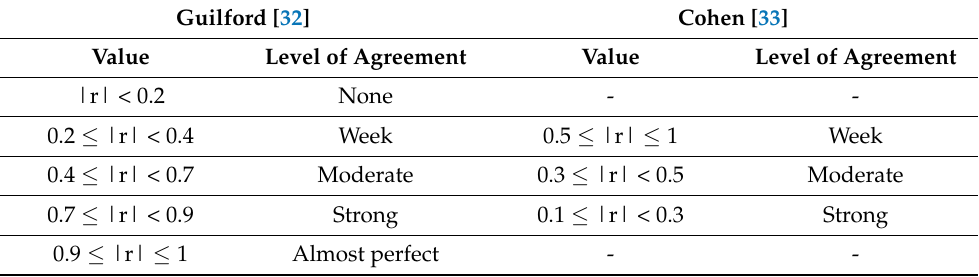
Table 10. Criteria for evaluation of correlation coefficient. Guilford [32] Cohen